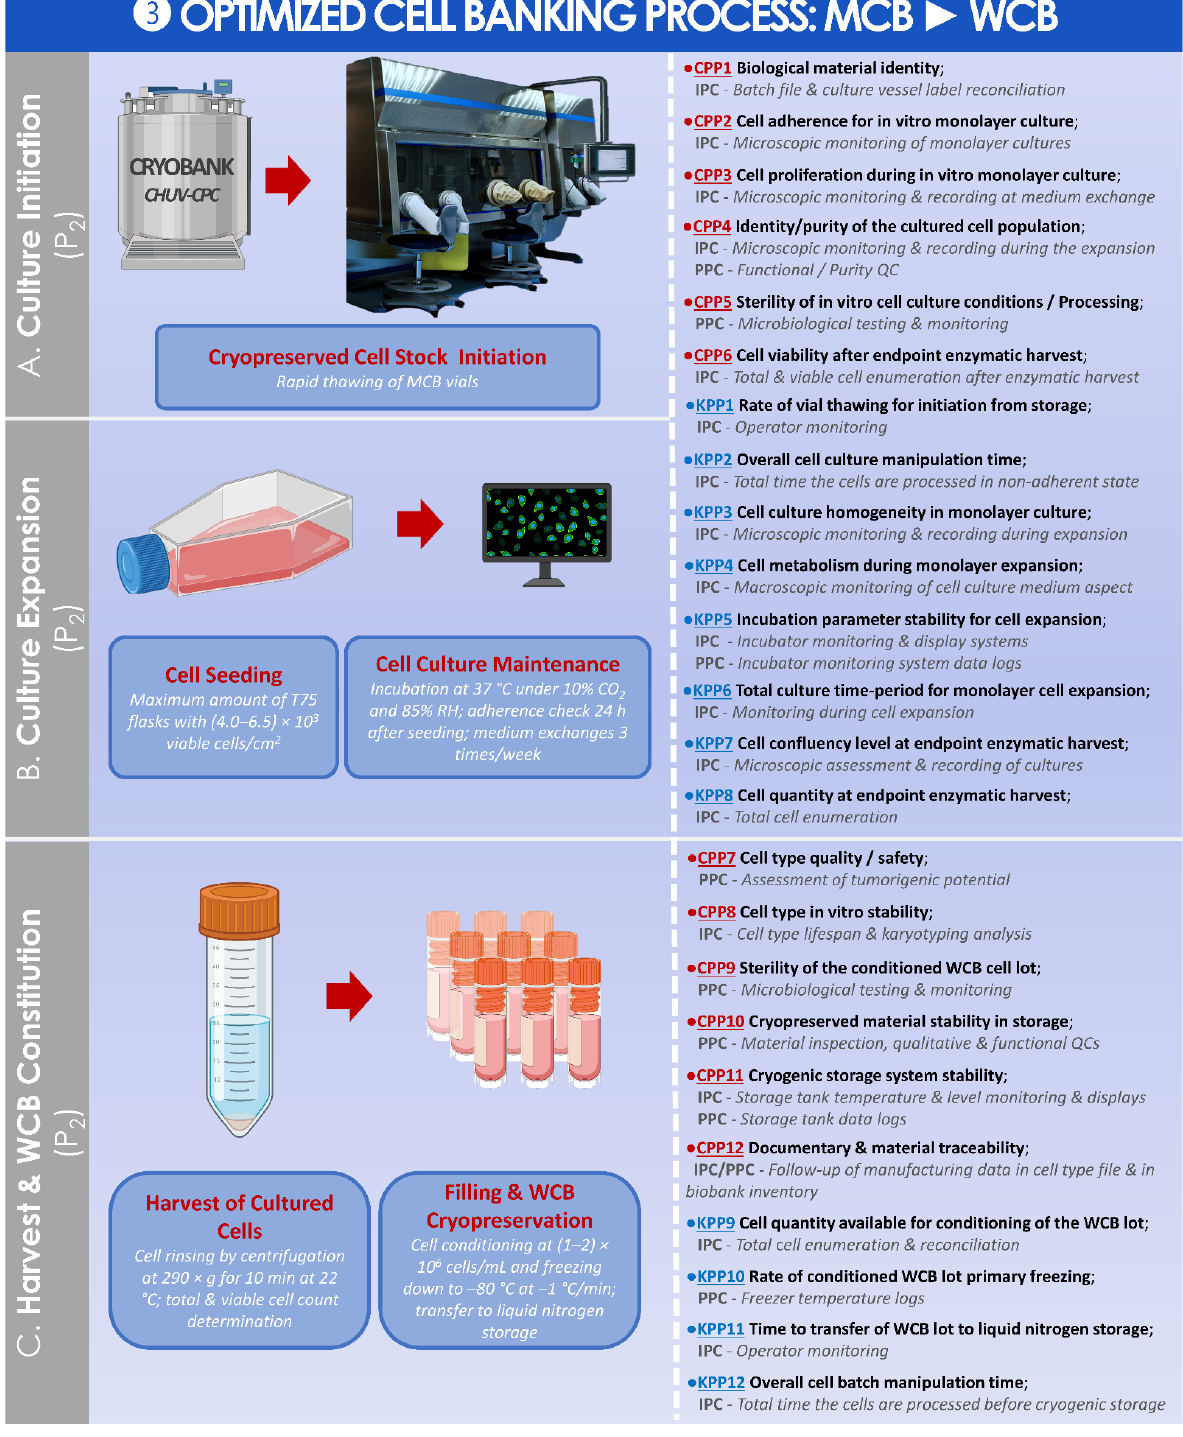
Figure 9. Optimized parametric and controlled process overview for the obtention of the WCB from the MCB. ( A ) Culture initiation of MCB materials for in vitro cell expansion. © CHUV-CPC. ( B ) Single in vitro cell expansion. ( C ) Harvest and cryopreservation of the obtained cells for establishment of the WCB. The established CPPs, KPPs, IPCs, and PPCs are further defined in the supplementary document–Process Parameters: Table SPP3. API, active pharmaceutical ingredient; CHUV,